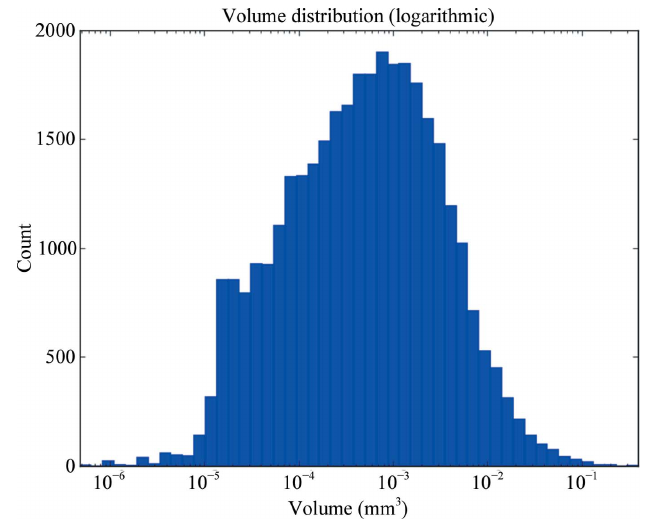
Figure 1 Histogram of crystal volumes. The histogram shows the distribution of crystal volumes measured on MASSIF-1. Note the logarithmic scale. N = 33